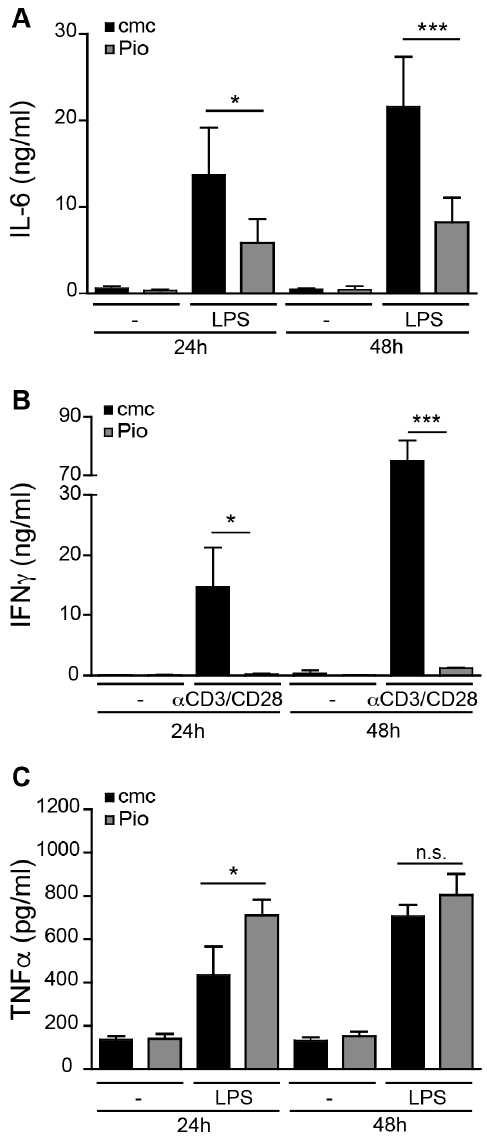
Figure 1. In vivo PPAR γ activation reduces pro-inflammatory activity in LSEC and splenic T cells but not Kupffer cells ex vivo. C57BL/6 mice were fed for 7 days with 30 mg/kg Pioglitazone (Pio) or with vehicle (cmc) alone. ( A ) LSEC were isolated from the livers of these mice and stimulated in vitro with 100 ng/mL of the TLR4 ligand LPS or were left untreated. After 24 and 48 h, IL-6 content in the supernatant was determined by ELISA. ( B ) CD8 T cells were isolated from the spleen and stimulated with plate-bound anti-CD3 ε /CD28 antibodies. Supernatants were analyzed for the IFN γ content by ELISA after 24 and 48 h. ( C ) Kupffer cells were isolated from Pio-treated and non-treated mice and incubated with 100 ng/mL LPS. TNF α content in the supernatant was measured after 24 and 48 h by ELISA. Data are presented as mean ± Standard Deviation (SD); one representative experiment out of three is shown. * p ≤ 0.05, *** p ≤ 0.001, n.s. = not significant.